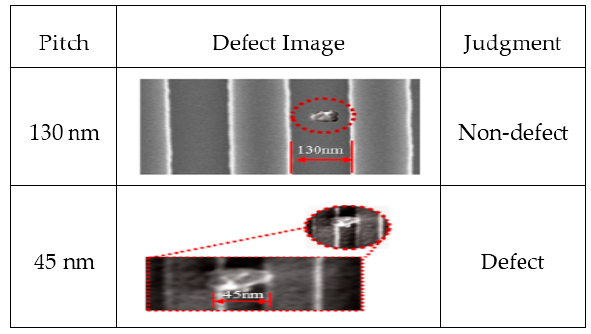
Figure 4. Change in the particle defect size with respect to the pitch.